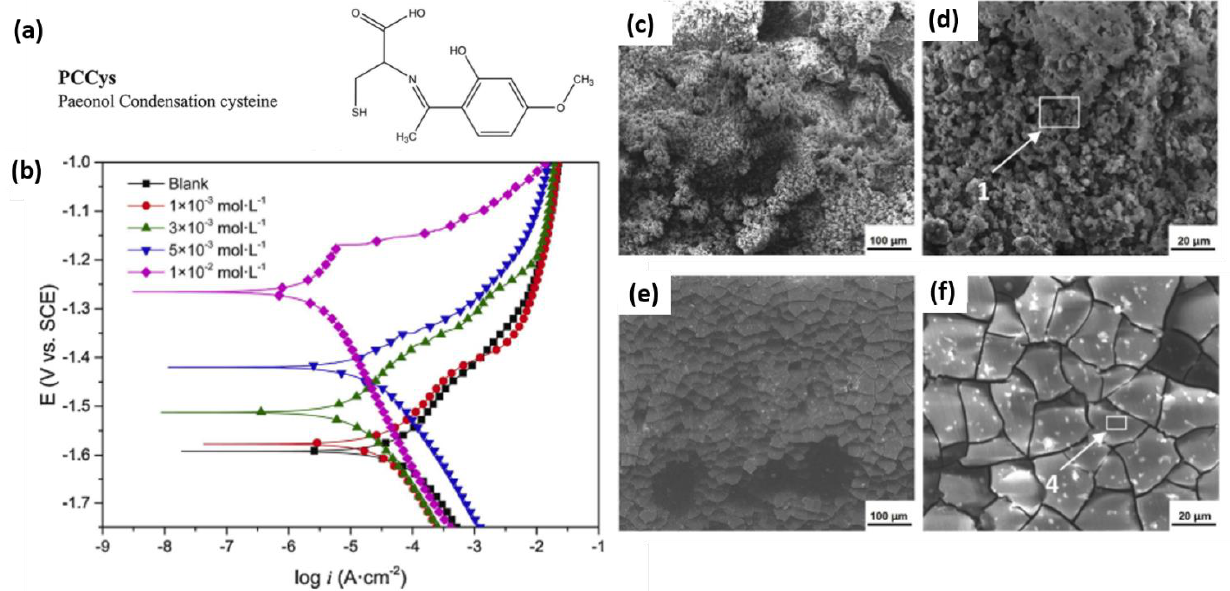
Figure 6. ( a ) Chemical structure of PCCys Schiff-based molecule. ( b ) Potentiodynamic polarization curves for Mg-Zn-Y-Nd alloy in 0.9 wt.% NaCl solution with and without different concentration of PCCys. ( c – f ) Corrosion morphologies of Mg-Zn-Y-Nd alloy after 7 days immersion in 0.9 wt.% NaCl solution: ( c , d ) without PCCys, ( e , f ) with 10 − 2 M PCCys. Numbers and arrows in ( d , f ) indicate the areas of EDS analysis carried out in the corresponding paper Adapted from [93] with permission from